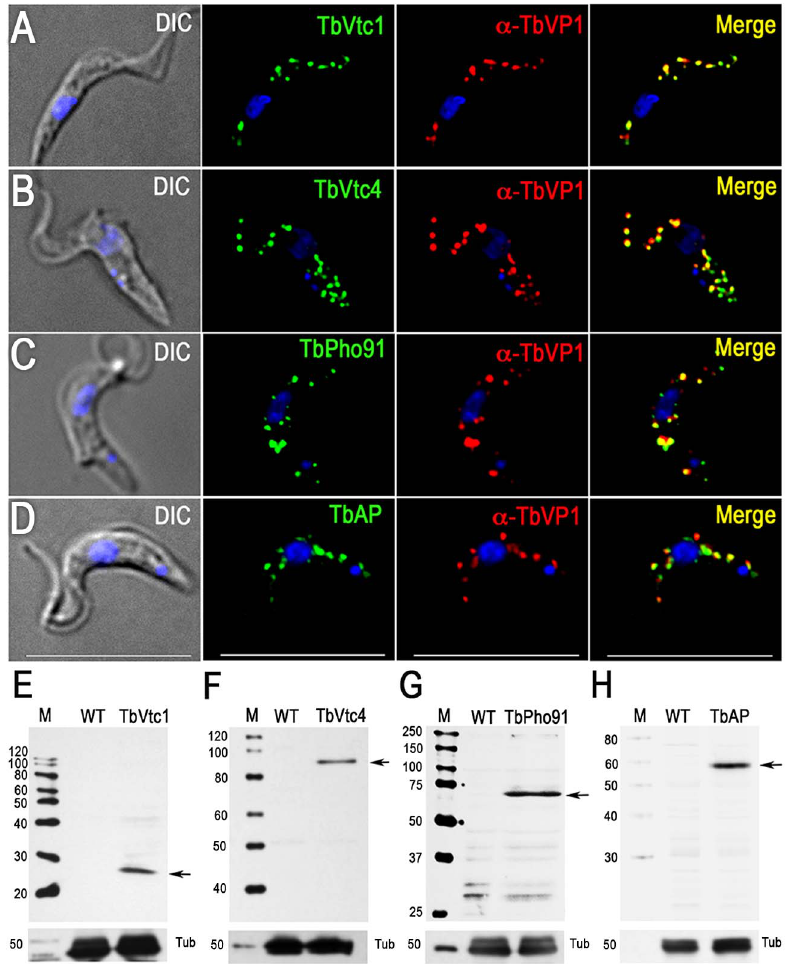
Fig. 3. Immunofluorescence microscopy and western blot analysis of proteins involved in phosphorus metabolism. TbVtc1 (A), TbVtc4 (B), TbPho91 (C), and TbAP (D) were 3 6 HA epitope-tagged in situ and co-localized with TbVP1 in acidocalcisomes of PCF trypanosomes (Pearson’s correlation coefficients of 0.873, 0.734, 0.728, and 0.680, respectively). Yellow in merge images indicate co-localization. Scale bars for (A– D)=10 m m. Western blot analyses with monoclonal anti-HA showing labeling of TbVtc1 (E), TbVtc4 (F), TbPho91 (G), and TbAP (H) in PCF trypanosomes. Molecular weight markers at left , and arrows show the corresponding bands identified. Tubulin ( Tub ) was used as a loading control.